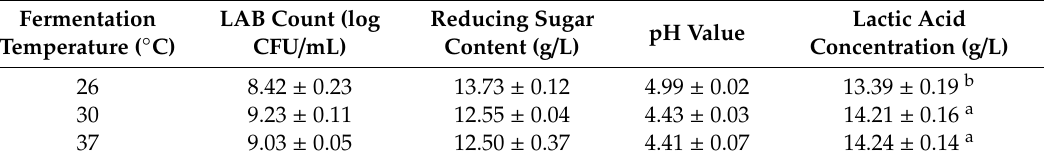
Table 6. The e ff ects of temperature on lactic acid fermentation.